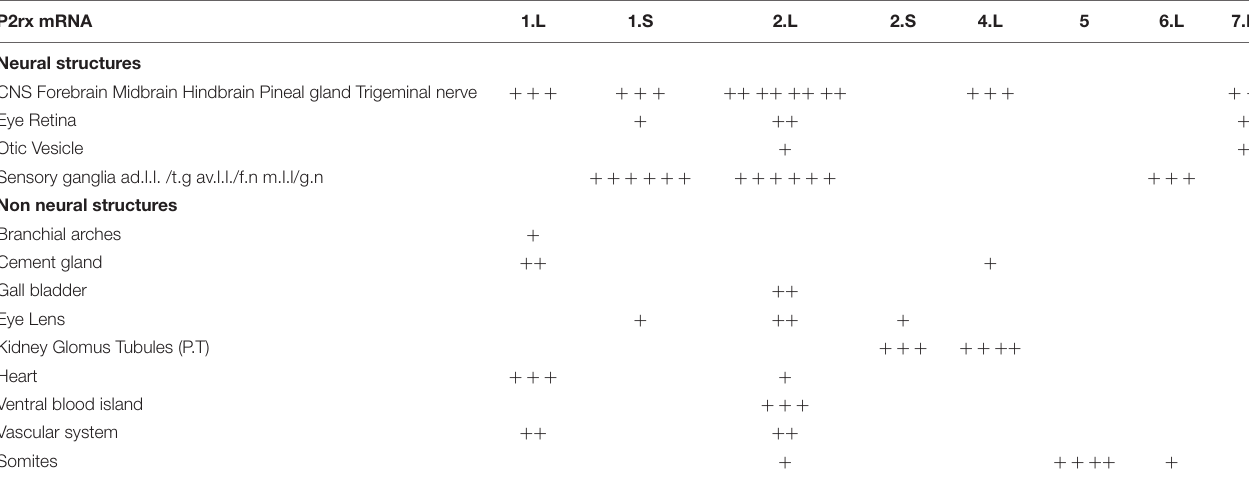
TABLE 2 | Summary of p2rx subunit expression domains in Xenopus late organogenesis stage embryos. P2rx